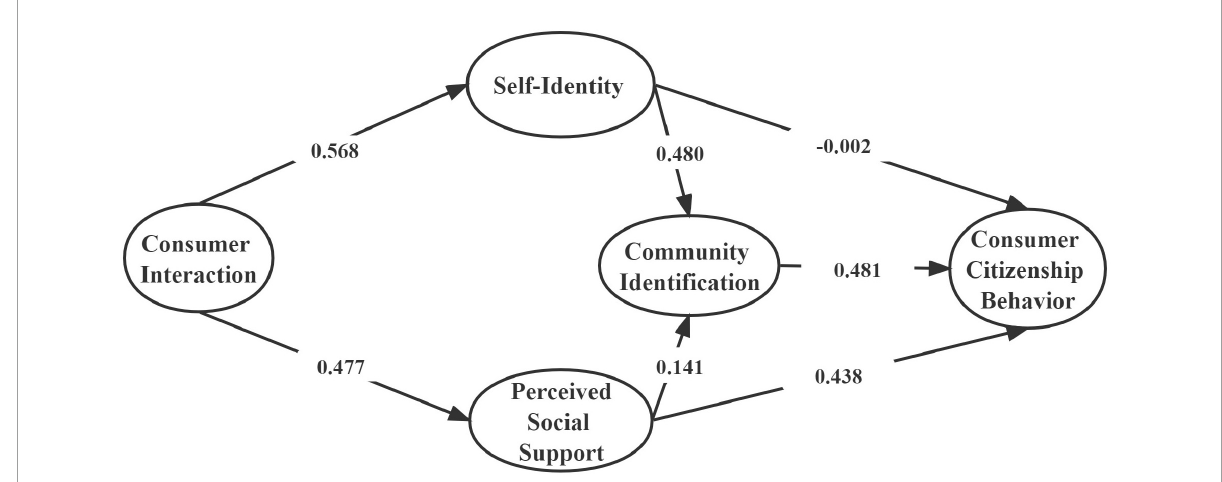
FIGURE2 Standardization path map of unlimited model of utilitarian motivation. χ 2 = 3755.774, df = 1696, χ 2 / df = 2.214, TCL = 0.941, CFI = 0.941, NFI = 0.897, RMSEA = 0.032.